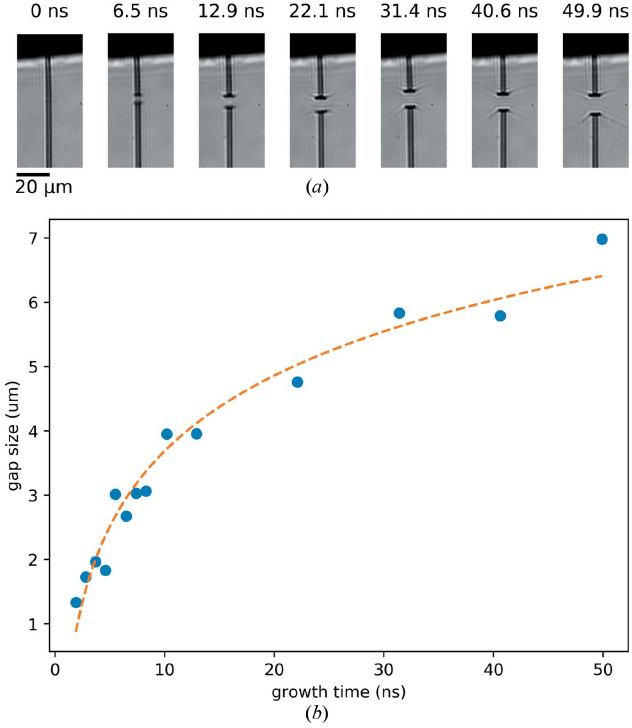
Figure 4 ( a ) Sideview images of a water jet at various delays after interception by a FLASH FEL pulse. ( b ) Plot of the evolution of the gap size in the first 50 ns after the FLASH FEL pulse hit the jet (solid circles) and the fit of a logarithmic function to the data (dashed line). The jet was flowing at a rate of 6.7 m l min (cid:2) 1 (helium mass-flow rate Q g = 2.6 mg min (cid:2) 1 ) with a diameter d jet = 3.1 m m and velocity v jet = 60 m s (cid:2) 1 . The dose deposited into the jet was approximately 30 MGy. Note that the position of the gap in the jet varies as a result of nozzle vibrations; the frames shown here are among those with the largest jet gaps recorded. The scale bar in the first panel of ( a ) is 20 m m and X-rays are incident from the